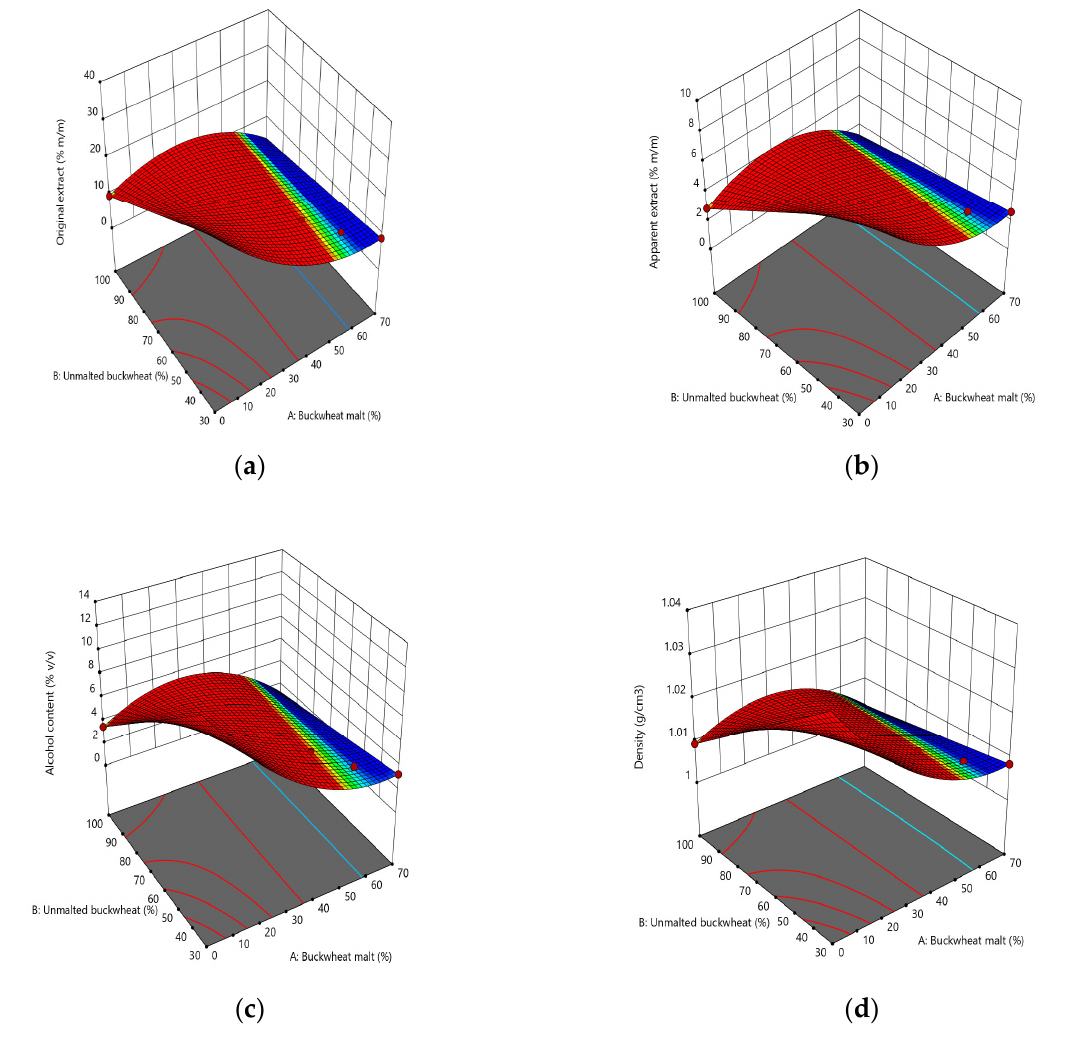
Figure 3. The graphical representations of the original extract ( a ), apparent extract ( b ), alcohol content ( c ), and density ( d ) as affected by the levels of unmalted buckwheat and buckwheat malt used in the beer recipe.